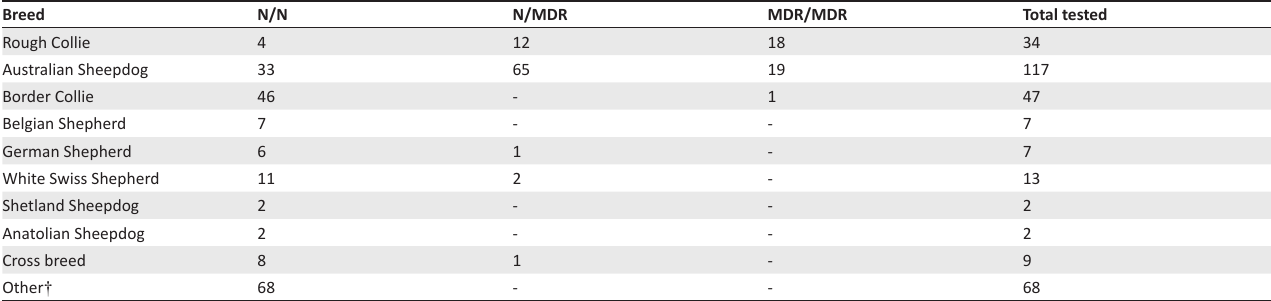
N, Normal or clear dogs; MDR, multi-drug resistance. † , Other dog breeds tested include Golden Retrievers, Labrador Retrievers, Bouvier des Flanders, Australian Cattledogs, Dobermans, Huskies and Dachshunds.